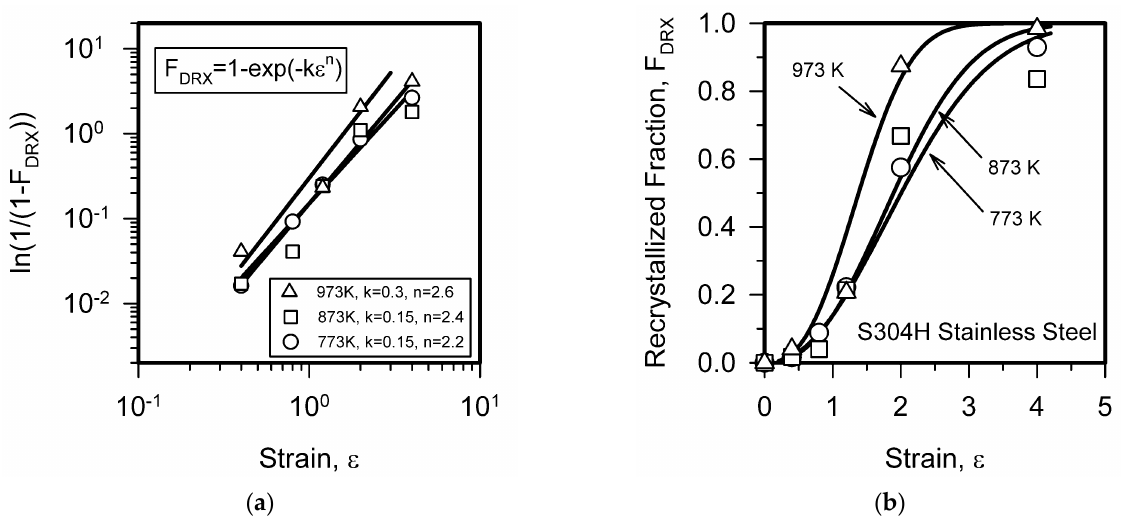
Figure 12. Effect of total strain on ln(1/(1 − F DRX )) ( a ) and UFG fraction ( b ) in a 304-type stainless steel subjected to multiple forging at indicated temperatures [70].